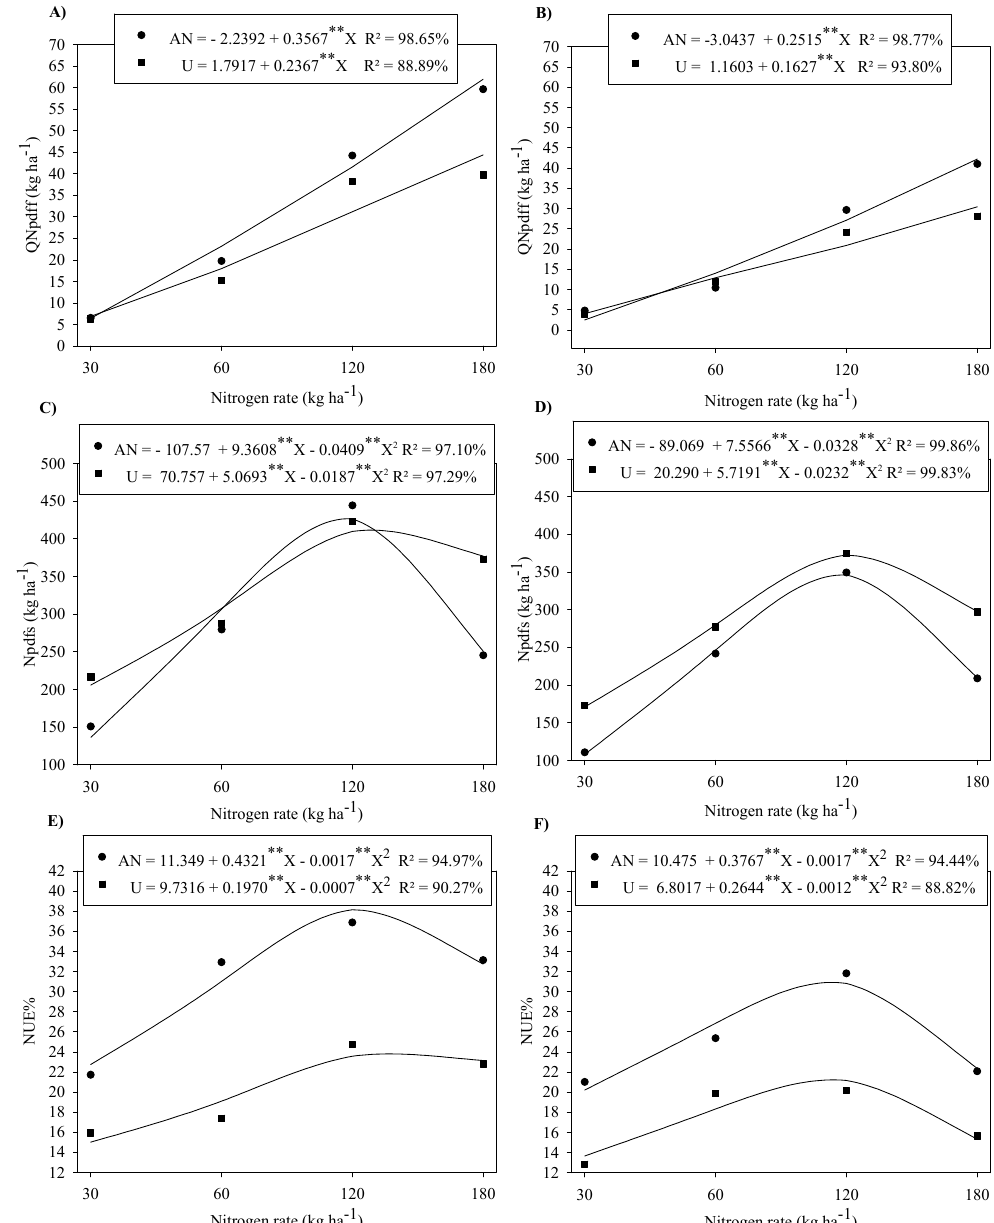
Figure 3. Amount of nitrogen in sugarcane plant derived from fertilizer (Npdff, kg ha − 1 ), amount of N in sugarcane plant derived from soil (Npdfs, kg ha − 1 ) and nitrogen use efficiency (NUE) by sugarcane plant, stalk ( A , C , E ), and pointer ( B , D , F ), in the cane plant cycle, as affected by N rate as ammonium nitrate (AN) and urea (U). ** Significant respectively at 1% probability according to test F.